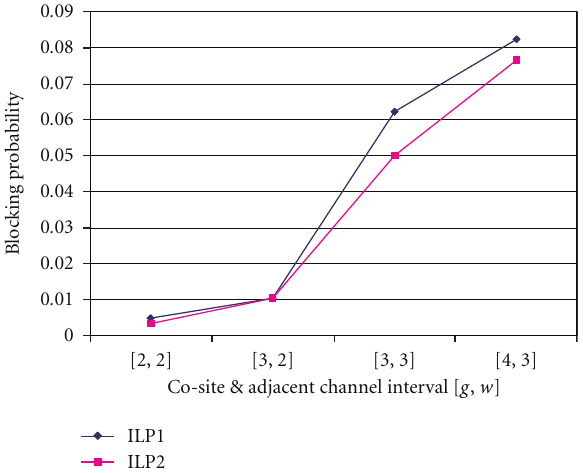
Figure 9: Performances of ILP1 versus ILP2 for ratio 21 :49 with initial tra ffi c load.